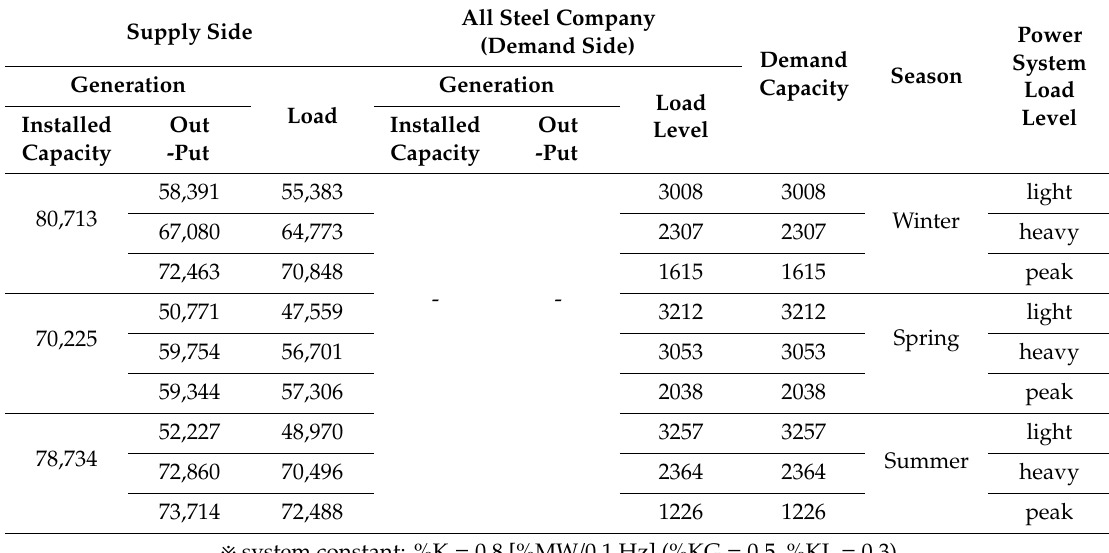
Table 9. Simulation data of the whole company.